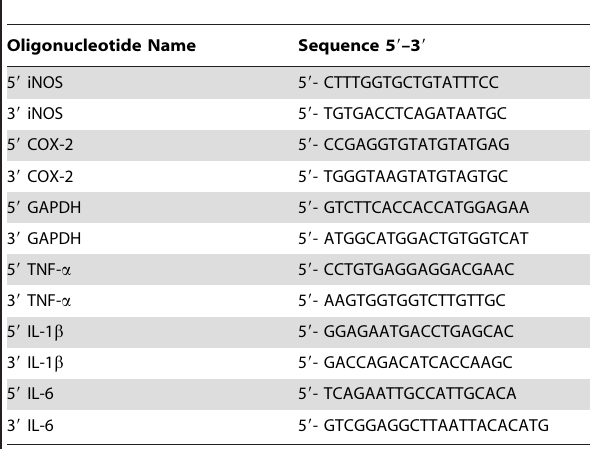
Table 1. Oligonucleotide sequences for real-time